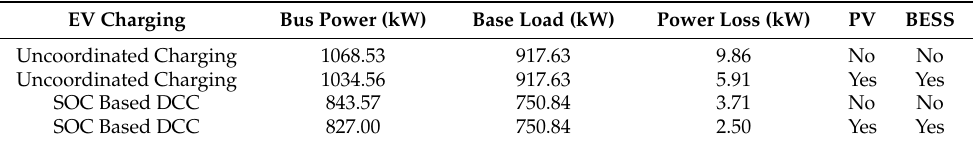
Table 2. EV charging effects on the grid at peak time.